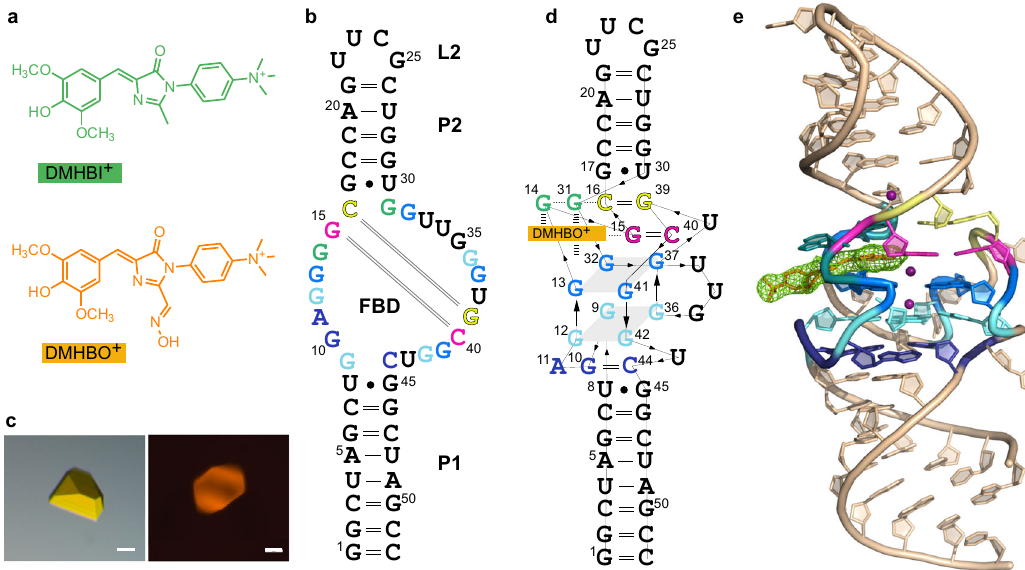
Fig. 1 Overall structure of the Chili – DMHBO + and Chili – DMHBI + complexes. a Chemical structures of DMHBO + and DMHBI + . b Sequence and secondary structure of the 52-nt Chili RNA. P paired region, L loop, FBD fl uorophore binding domain. Nucleotides shown in the same color interact by H- bonding in base pairs (green, pink, and yellow), base triple (dark blue), or G-quartets (light blue and cyan). c Images of representative Chili – DMHBO + crystals under white light (left) and UV irradiation with a mercury vapor lamp and fl uorescence fi lter set (right). Scale bar: 20 µ m. Images of n = 15 crystals were taken with similar results. d Tertiary fold diagram of Chili – DMHBO + . Thin lines with embedded arrows indicate 5 ′ − 3 ′ connectivity. e Crystal structure of the Chili – DMHBO + complex. Color code of nucleotides in the FBD as in panels b and d . The green mesh represents the polder omit map of the DMHBO + ligand contoured at 4 σ